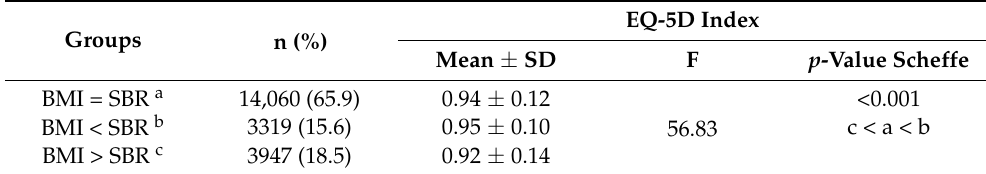
Table 5. Comparison of EQ-5D index in each body image perception and actual weight status group.